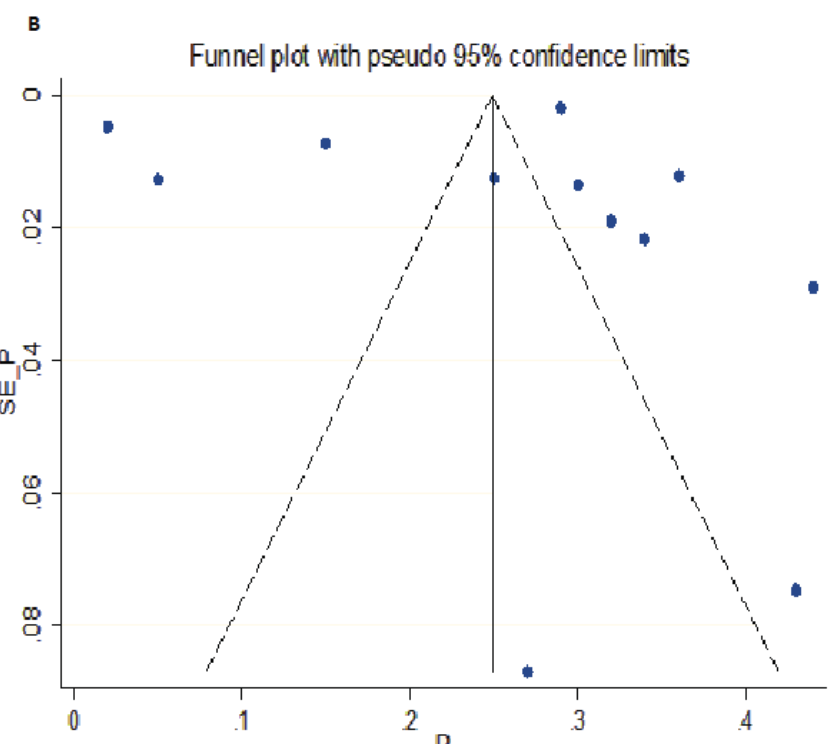
Fig 2. A: Forest plot; pooled estimate prevalence of insomnia during coronavirus epidemics sub-grouped by the study population. B: Funnel plot; no publication bias observed in studies (Egger’s test p-value =